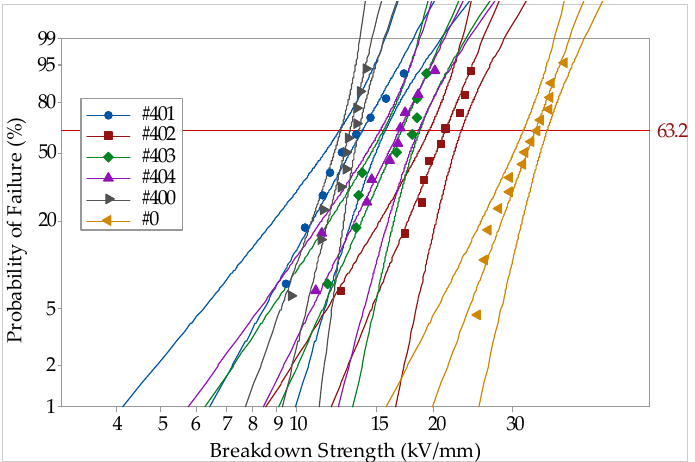
Figure 3. Weibull distribution of breakdown field strength of composites with different SiO 2 content.